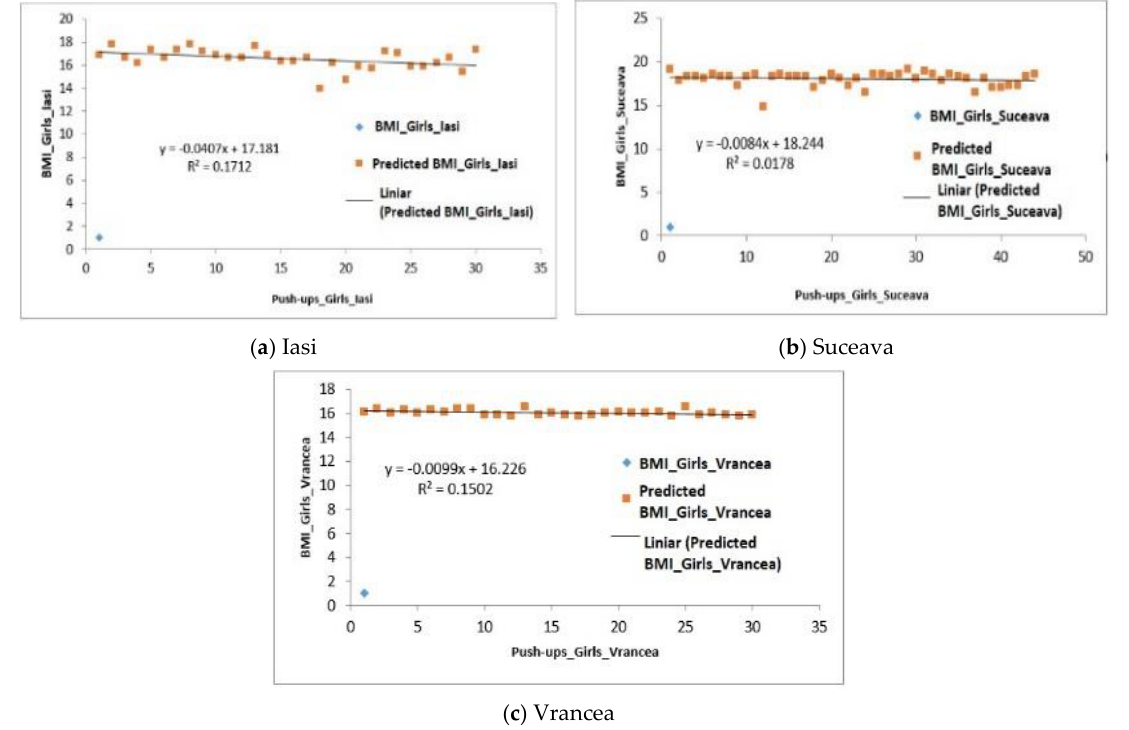
Figure 2. Relationship between the BMI and the number of push-ups performed by the girls in the three regions.